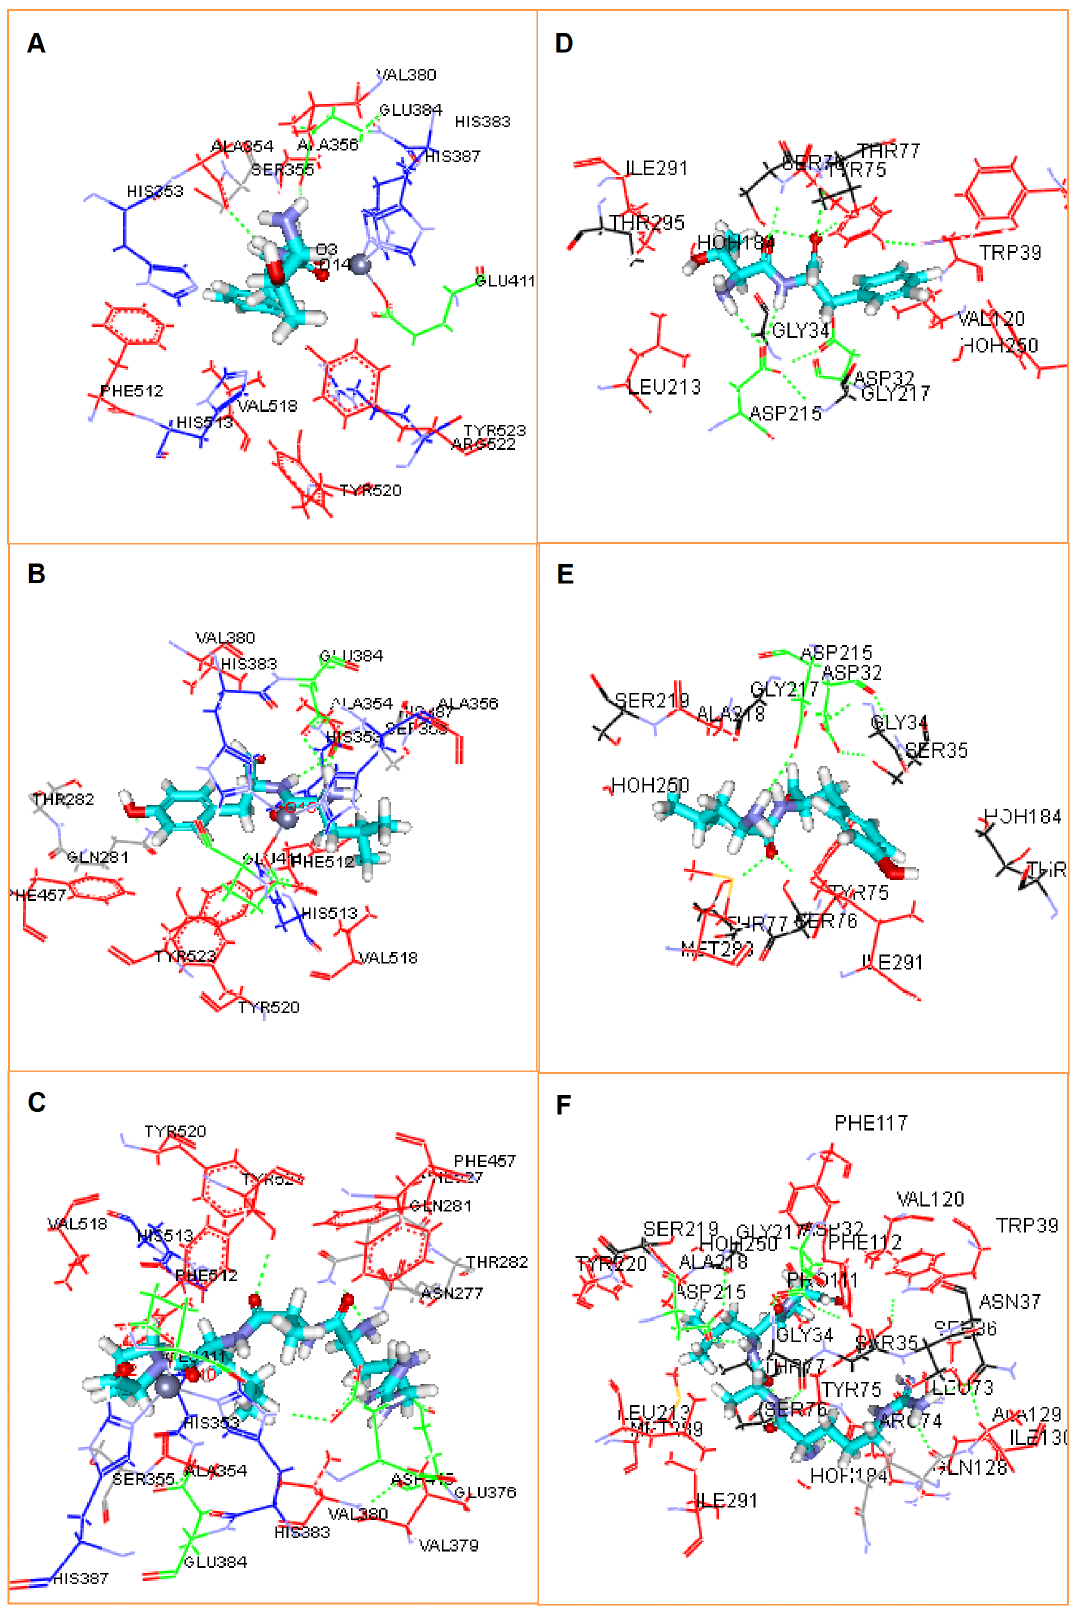
Figure 4. Molecular docking of the peptides at ACE and renin active sites. Results of peptide-ACE interactions are showed in A (TF), B (LY), C (RALP), and that of peptide-renin interactions are D (TF), E (LY), F (RALP). Enzyme hydrophobic residues are represented in red, positively charged